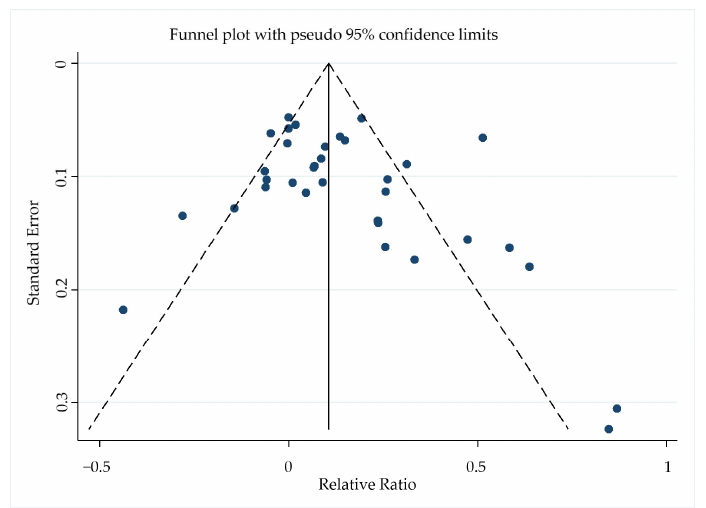
Figure 7. Funnel plot of the 26 included studies with pseudo − 95% confidence limits based on the relative ratio for regression rates.